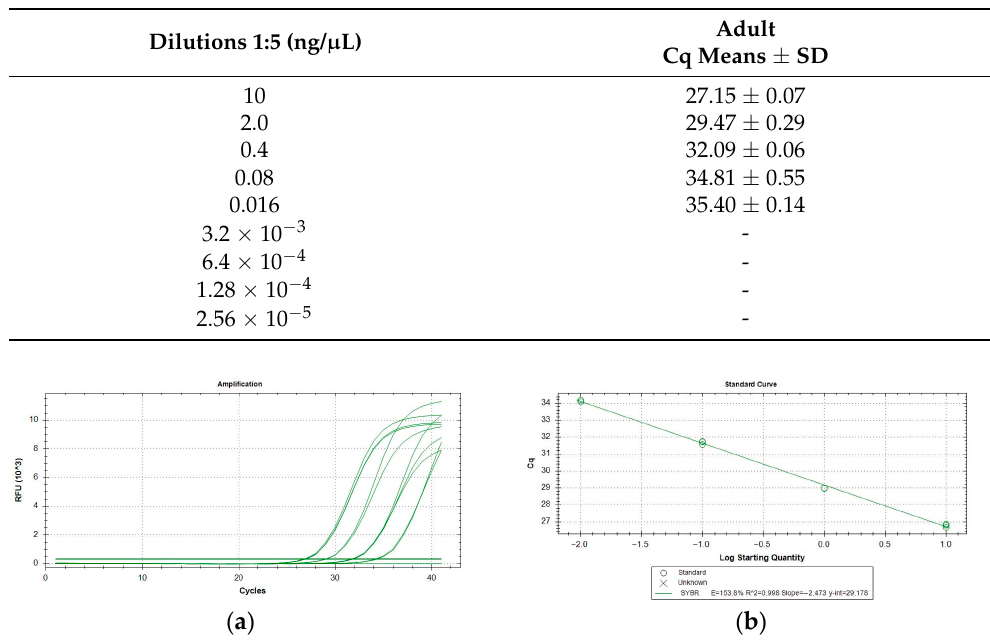
Figure 3. P. italosignus : serial dilutions 1:5 from 10 ng of adult DNA extracts, showing amplification ( a ) and titration curves ( b ). Table 3. P. italosignus : repeatability and reproducibility values (average ± SD) of the assay.